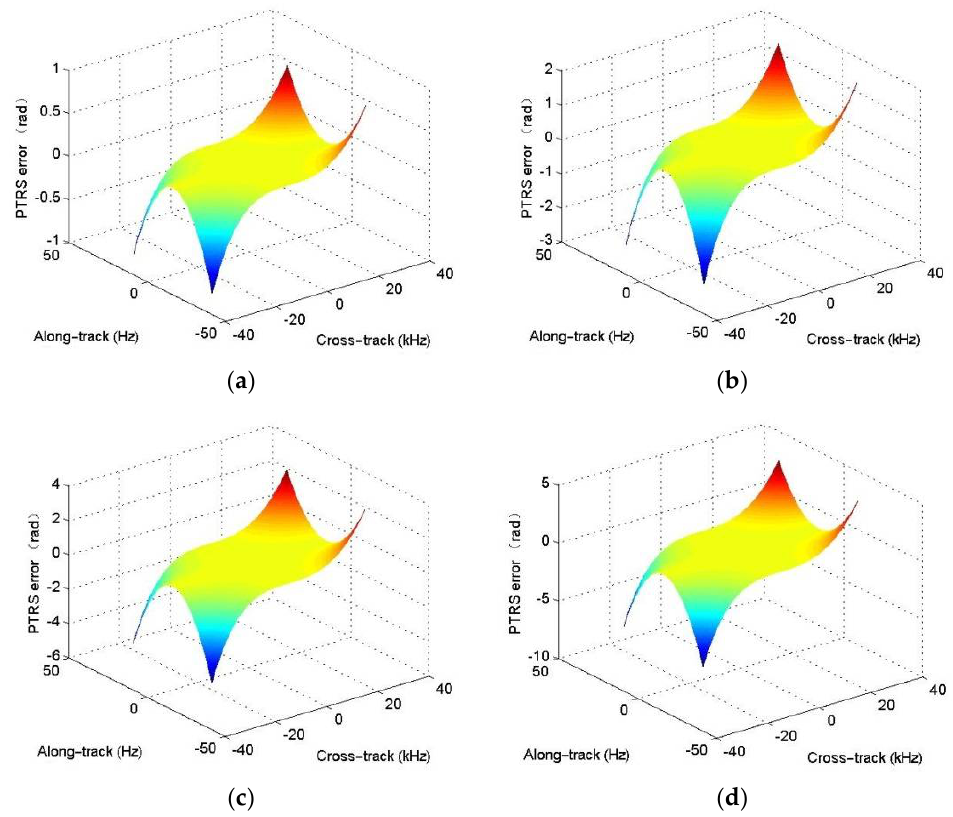
Figure 9. PTRS error for the last transmitter/receiver pair when the system works with a wide-band- width. ( a ) r = 40 m; ( b ) r = 110 m; ( c ) r = 180 m; ( d ) r = 250 m.